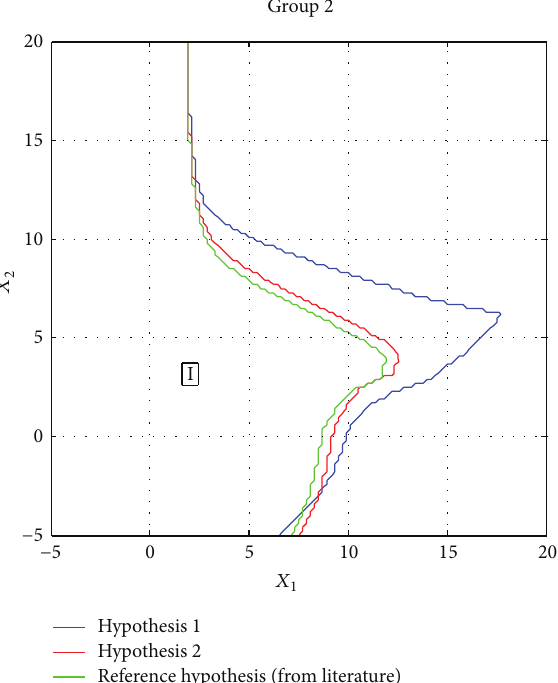
Figure 11: Production policy for 𝑃 1 and setup policy (product 1 to product